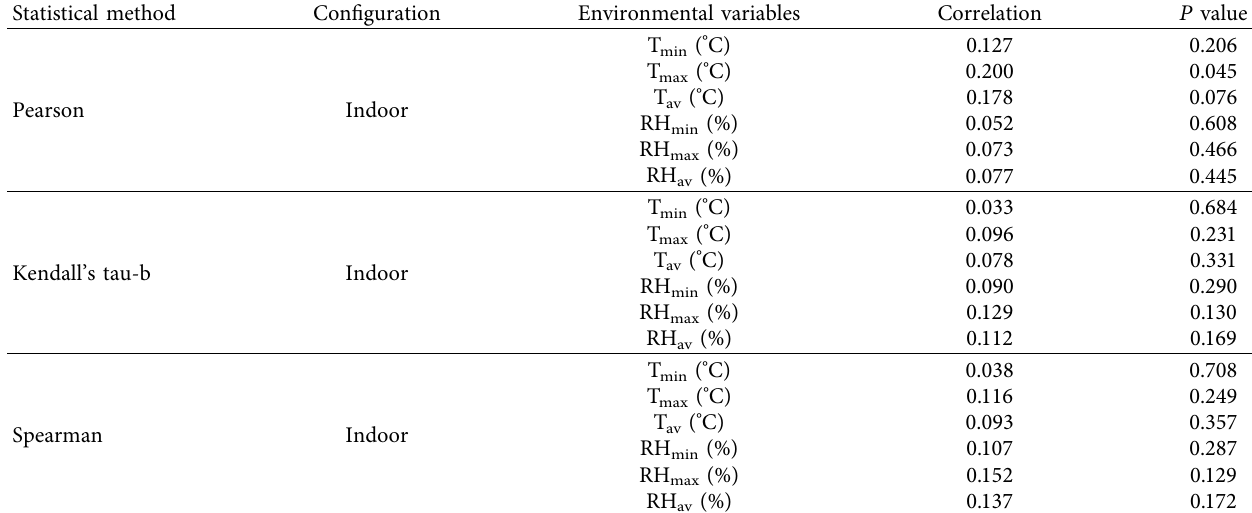
Table 3: Pearson, Kendall’s tau-b, and Spearman correlations between meteorological factors and COVID-19-infected cases for indoor